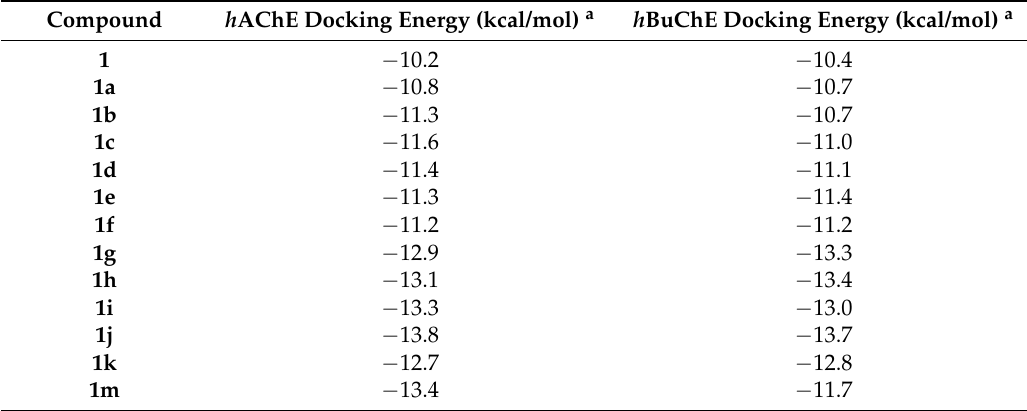
Table 2. Calculated binding energies for the top-scored docking poses of 1a – 1m . Compound